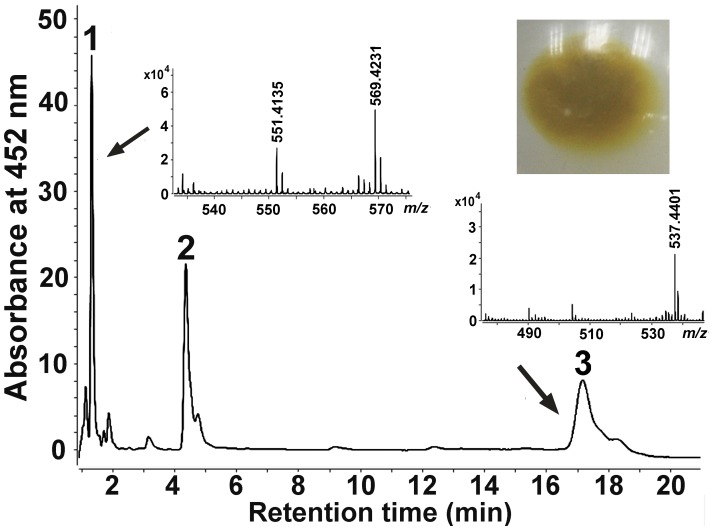
HPLC analysis and positive-ion APCI-MS spectra of the carotenoids produced by Sphingobium yanoikuyae XLDN2-5.The following carotenoids were identified: peak 1 was identified as zeaxanthin ([M+H]+ at m/z = 569.4231, and [M+H-H2O]+ at m/z = 551.4135); peak 2 was identified as β-cryptoxanthin; Peak 3 was identified as β-carotene ([M+H]+ at m/z = 537.4401). Insets show cell pellets from strain XLDN2-5.